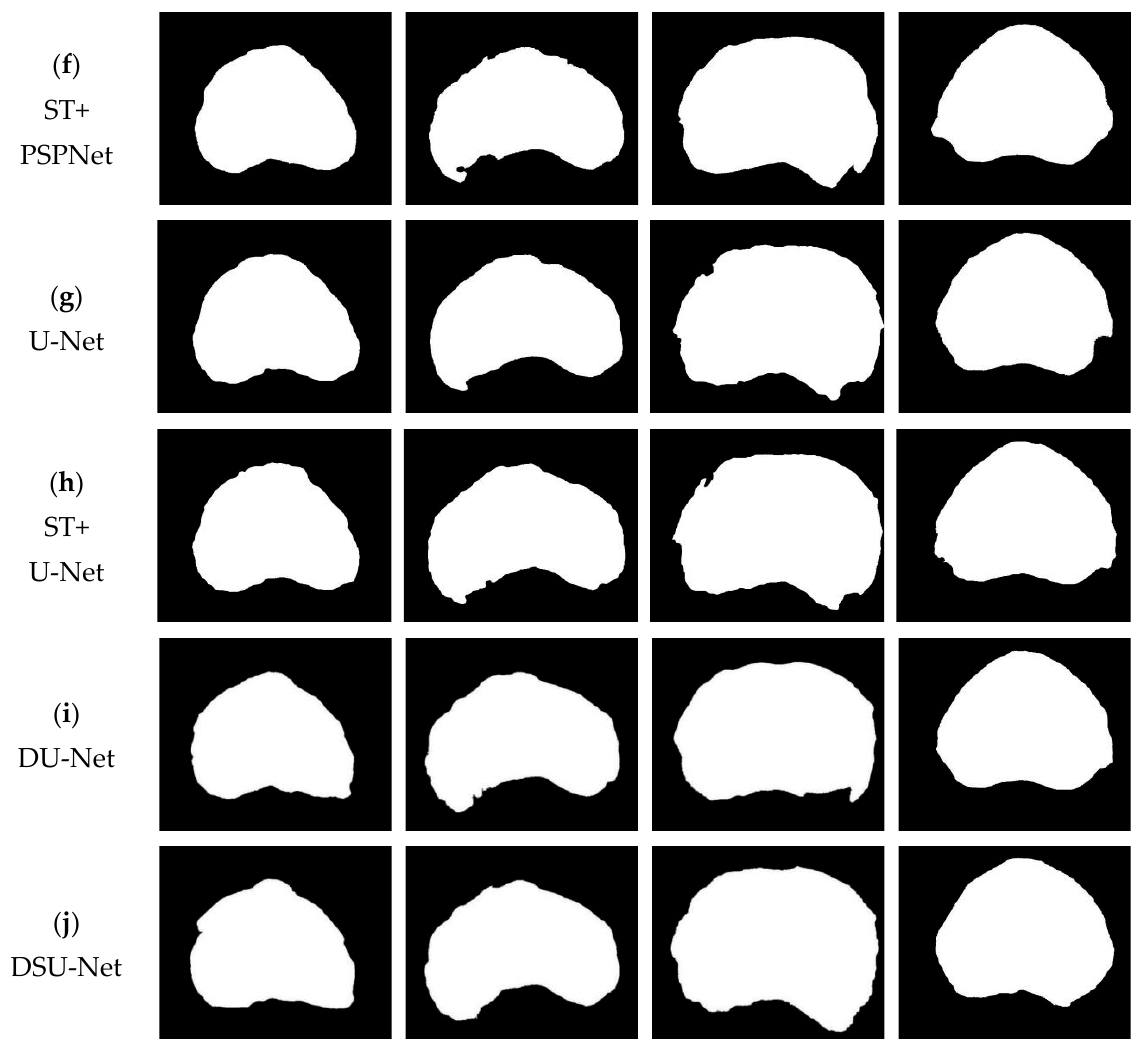
Figure 6. Visualized results of the segmentation experiment comparison method.